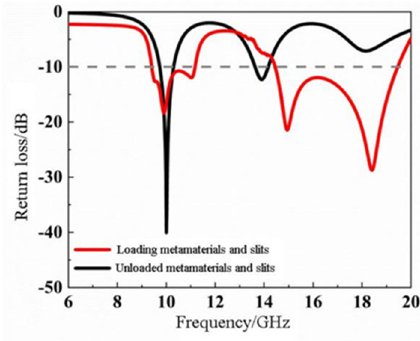
Figure 13. Comparison of the return loss curves of a nested double-hexagon ring-shaped metamate- rial slot microstrip antenna and a reference